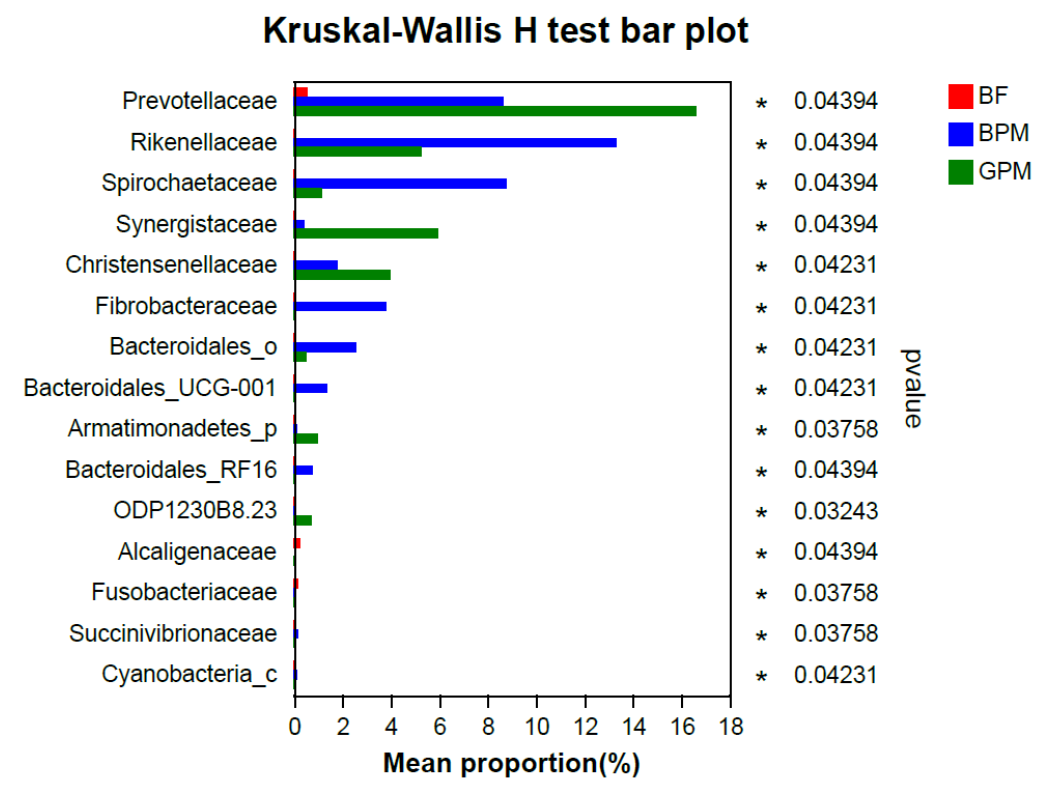
Figure 4. Differential gut microbiota analysis of young elephants. *: Significant difference.